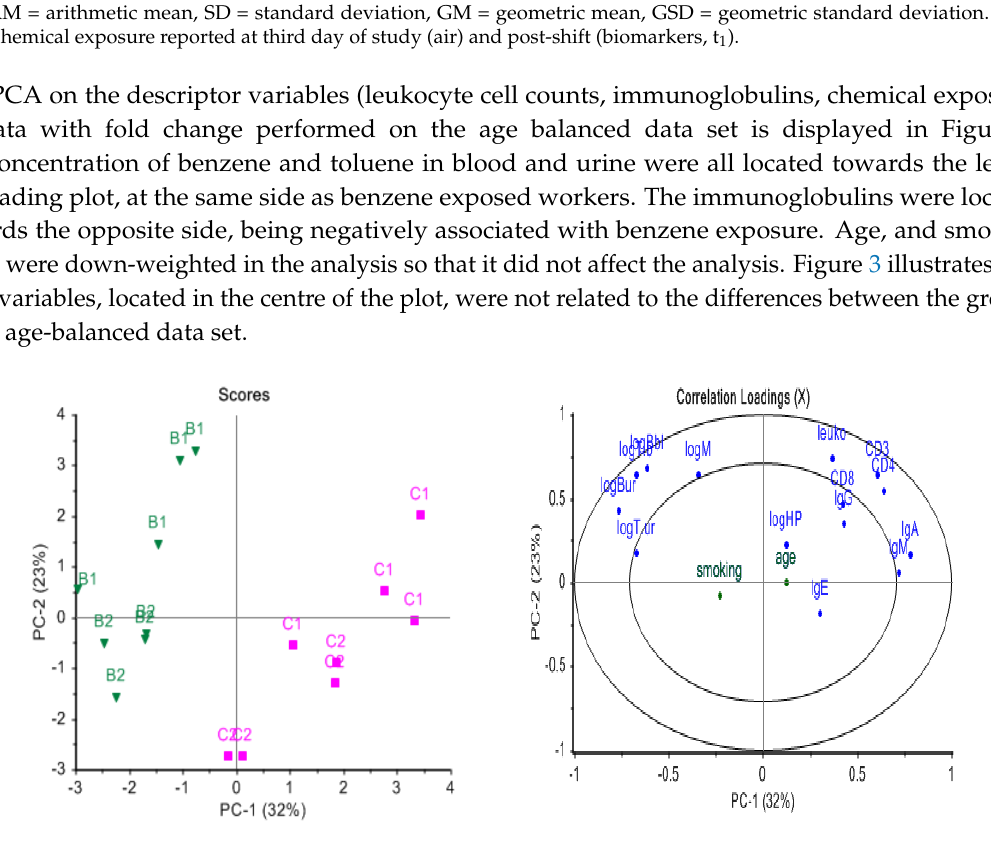
Figure 3. Explorative multivariate analysis, Principal Component Analysis (PCA) of the fold change of descriptive data between time 1 and 2 for the age balanced dataset, where all features were standardized to unit variance. ( a ) score plot of the samples and ( b ) corresponding loading plot. Benzene exposed subjects are shown to the left in green (B) and referents to the right in pink (C), where 1 = time 1 (post-shift), 2 = time 2 (pre-next shift). The variables that clustered on top of each other towards